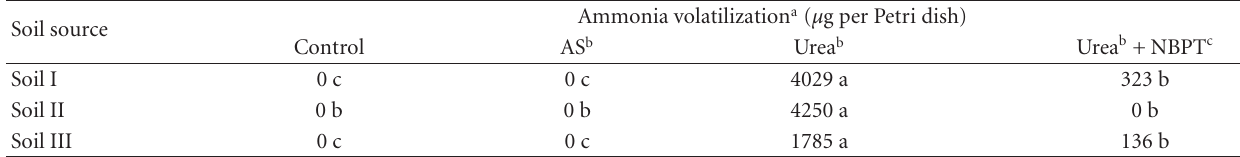
Table 2: Ammonia volatilization from three di ff erent soils with ammonium sulfate, urea, and urea + NBPT in comparison with zero N input (control) in Petri dish incubation